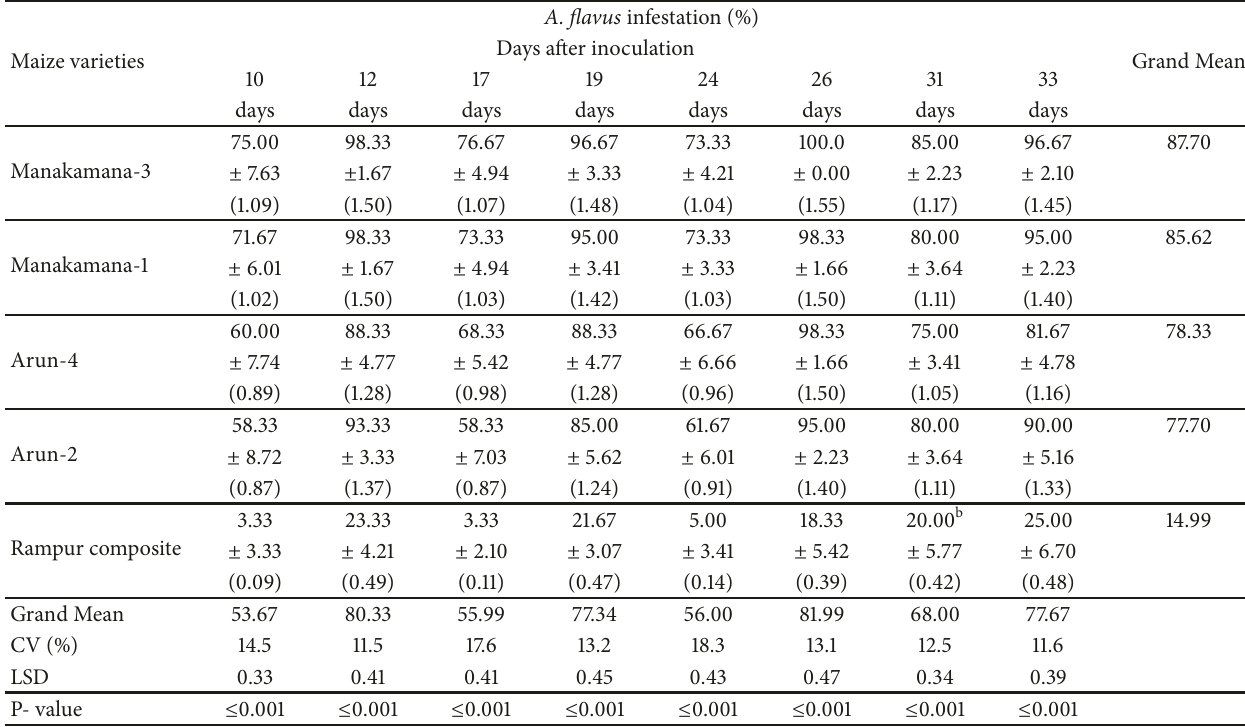
A. flavus infestation (%)